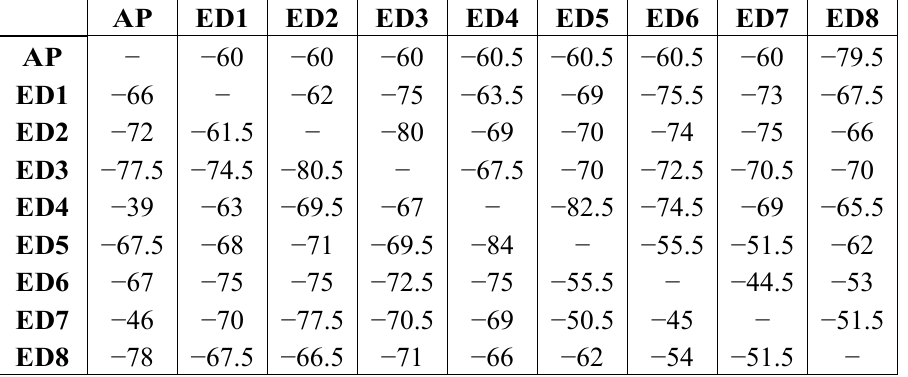
Table 1. Sample RSSI Table at the